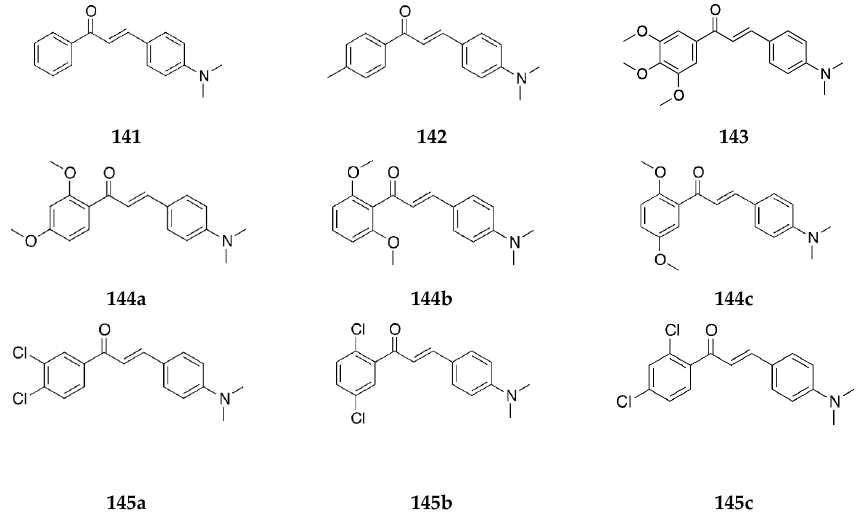
(cid:48) -aminochalcones